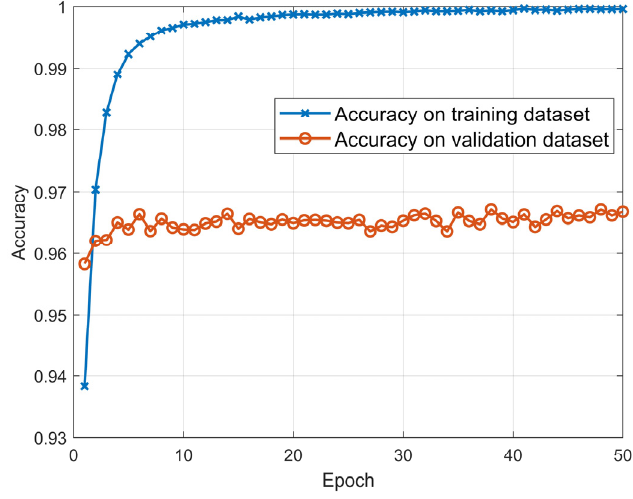
Figure 3. The average recognition rates of CNN-1D-AM on the training dataset and validation dataset with di ff erent quantity of training epochs.